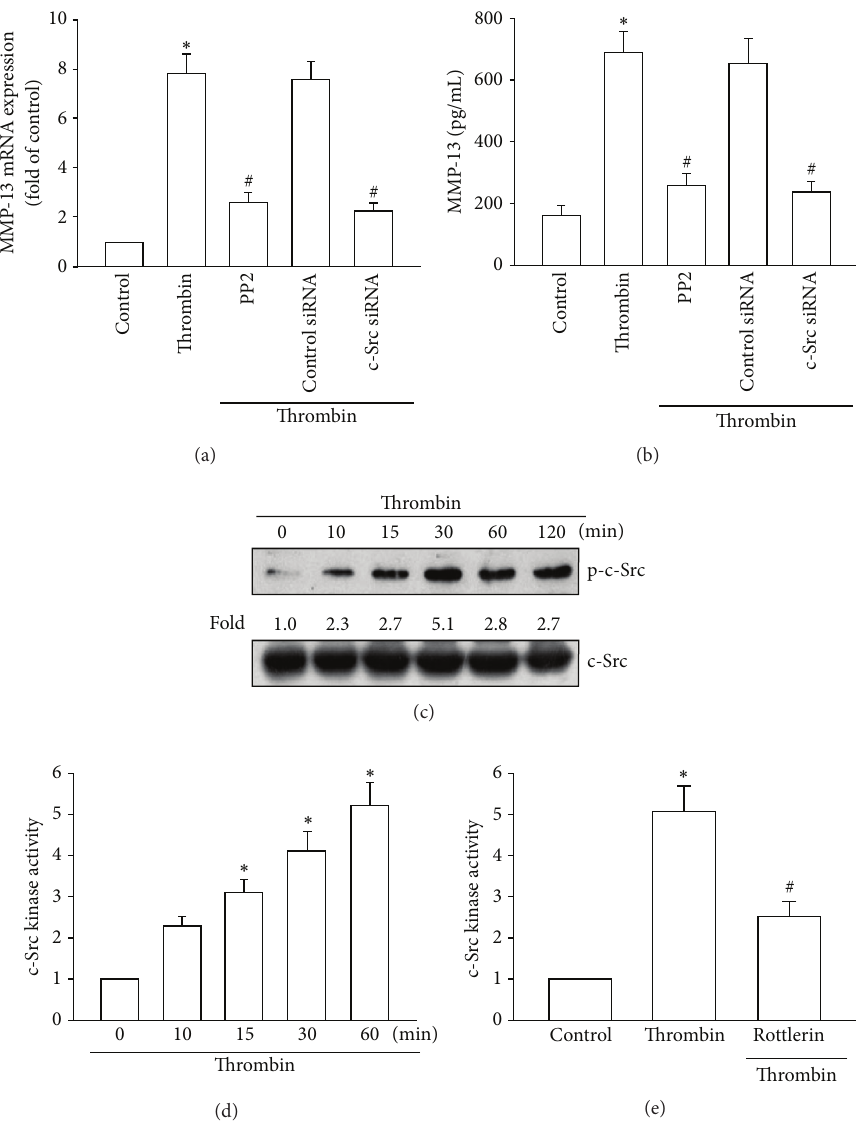
Figure 3: Activation of c-Src in thrombin-mediated MMP-13 expression in chondrocytes. ((a) and (b)) qPCR and ELISA analyses of MMP-13 expression in chondrocytes that were pretreated for 30min with PP2 (3 𝜇 M) or transfected with c-Src siRNA for 24h and then stimulated with thrombin for 24 h. ((c) and (d)) Western blotting analysis of phosphorylation and kinase activity of c-Src in cells incubated with thrombin for the indicated time intervals. (e) Kinase activity of c-Src in chondrocytes pretreated for 30min with rottlerin and stimulated with thrombin for 60min. ∗ 𝑃 < 0.05 as compared with basal levels. # 𝑃 < 0.05 as compared with the levels in the thrombin-treated